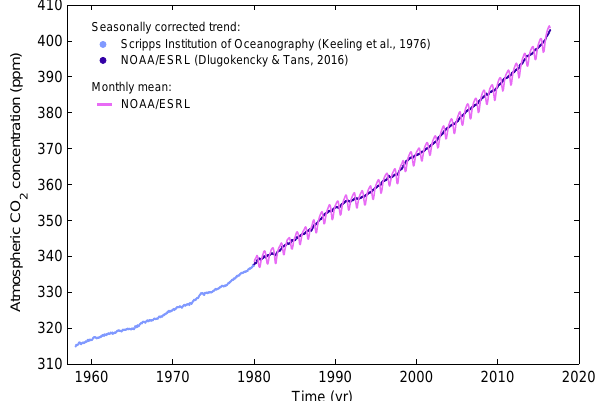
Figure 1. Surface average atmospheric CO 2 concentration, de- seasonalised (ppm). The 1980–2016 monthly data are from NOAA/ESRL (Dlugokencky and Tans, 2016) and are based on an average of direct atmospheric CO 2 measurements from mul- tiple stations in the marine boundary layer (Masarie and Tans, 1995). The 1958–1979 monthly data are from the Scripps Institu- tion of Oceanography, based on an average of direct atmospheric CO 2 measurements from the Mauna Loa and South Pole stations (Keeling et al., 1976). To take into account the difference of mean CO 2 between the NOAA/ESRL and the Scripps station networks used here, the Scripps surface average (from two stations) was har- monised to match the NOAA/ESRL surface average (from multiple stations) by adding the mean difference of 0.542ppm, calculated here from overlapping data during 1980–2012. The mean seasonal cycle is also shown from 1980 (in pink).